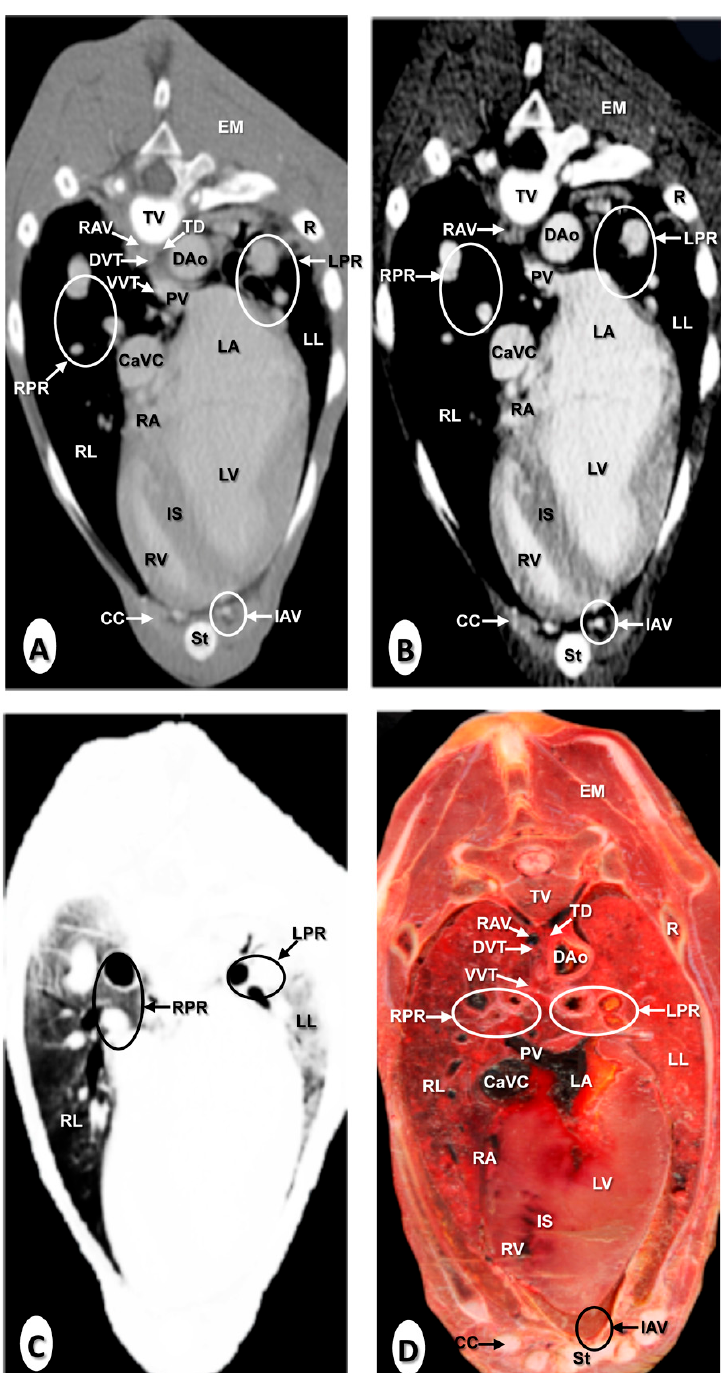
Figure 5. Transverse images at the level of the lung roots. ( A ) CT bone window; ( B ) CT mediastinal window; ( C ) CT lung window; and ( D ) anatomic section. These images are displayed so that the right side of the foal is to the viewer’s left and the dorsal view is at the top. Caudal cava vein (CaCV); descending aorta (Dao); dorsal vagal trunk (DVT); epaxial muscles (EM); internal thoracic artery and vein (IAV); left atrium (LA); left lung (LL); left pulmonary root (LPR); pulmonary vein (PV); rib: Costal bone (R); rib: Costal cartilage (CC); right atrium (RA); right azygos vein (RAV); right lung (RL); right pulmonary root (RPR); right ventricle (RV); scapula (Sca); sternum (St); thoracic duct (TD); thoracic vertebra (TV); and ventral vagal trunk (VVT).